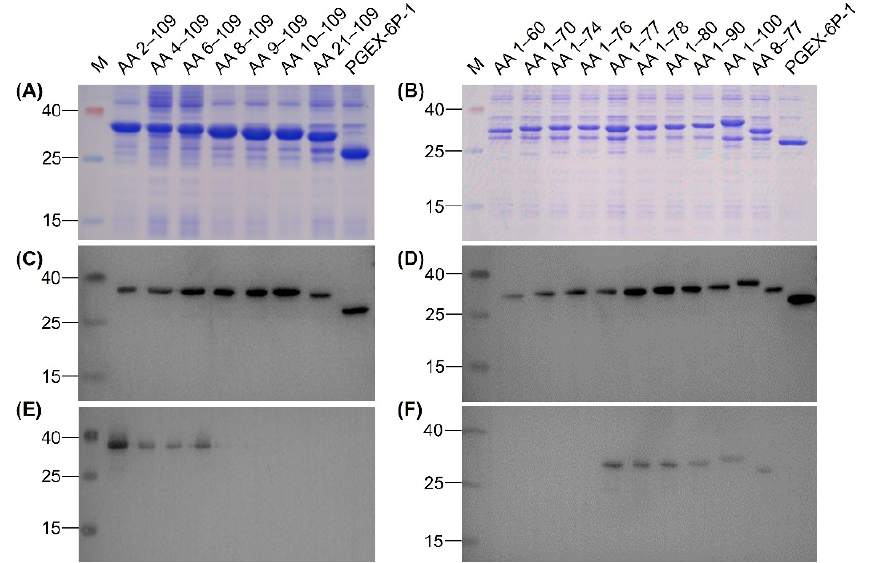
Figure 5. Identification of epitope recognized by 12F11. ( A ) Analysis of the N-terminal truncated rEDIII proteins by SDS-PAGE. ( B ) Analysis of the C-terminal truncated rEDIII proteins and the N- and C-terminal truncated rEDIII protein by SDS-PAGE. ( C ) Identification of the N-terminal truncated rEDIII proteins by Western blot assay using anti-GST MAb. ( D ) Identification of the C-terminal truncated rEDIII proteins and the N- and C-terminal truncated rEDIII protein by Western blot assay using anti-GST MAb. ( E ) Analysis of recognition of 12F11 to the N-terminal truncated rEDIII proteins. ( F ) Analysis of recognition of 12F11 to the C-terminal truncated rEDIII proteins and the N- and C-terminal truncated rEDIII protein. The truncated rEDIII proteins are shown above pictures. The numbers on the left of the pictures indicate molecular weight standards (in